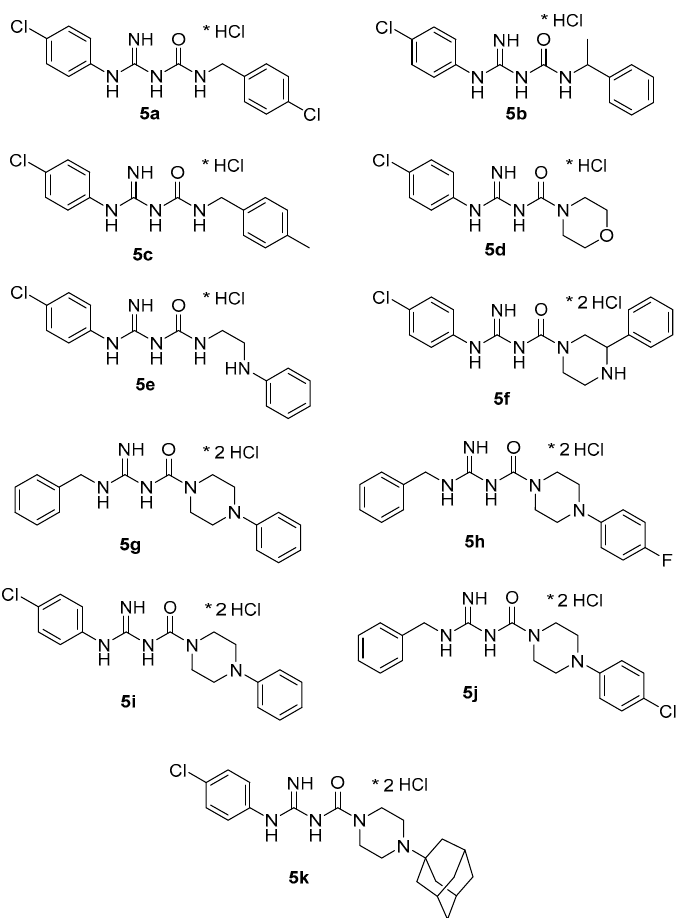
Figure 2. Structures of the amidinourea derivatives 5a – k.